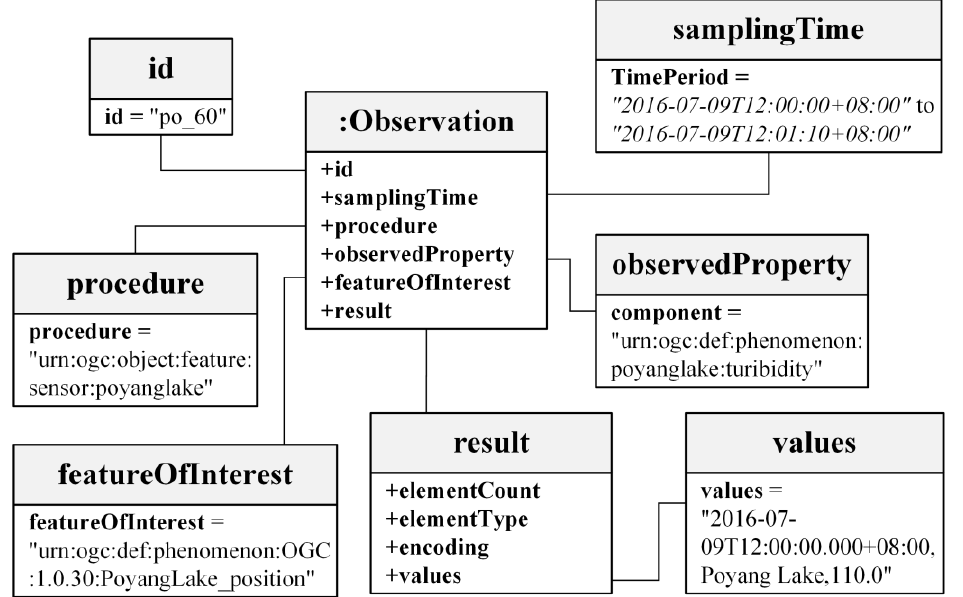
Figure 8. An instance of the Observation class.